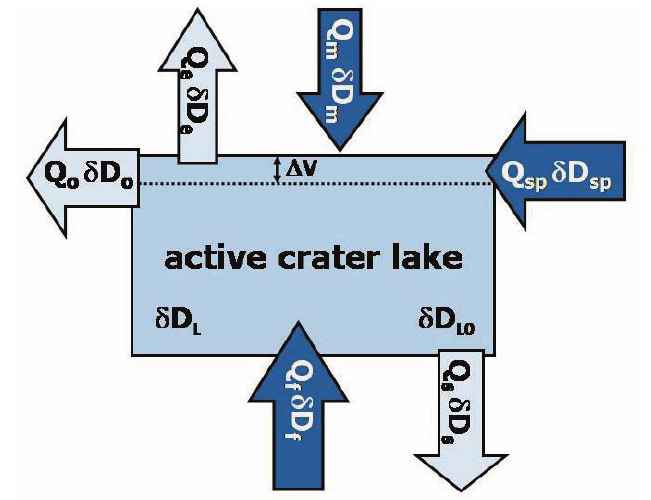
Figure 5. Box model for the isotope budget, observed for a period of time t to 0